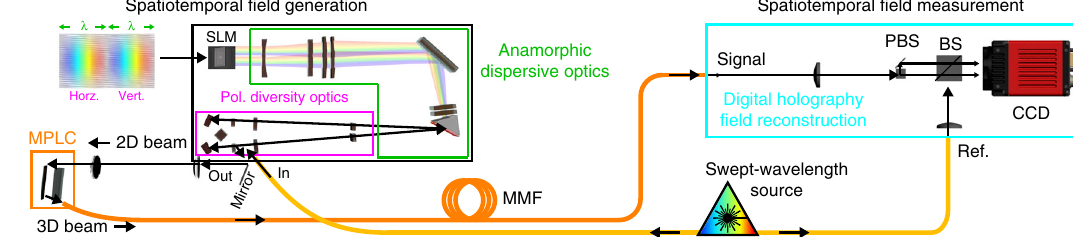
Fig. 2 Schematic of spatiotemporal fi eld generation and characterisation apparatus. A polarisation and spatially resolved spectral pulse shaper for generating arbitrary vector spatiotemporal states, in conjunction with a swept-wavelength digital holography system for characterisation. All characterisation and results are measured in the